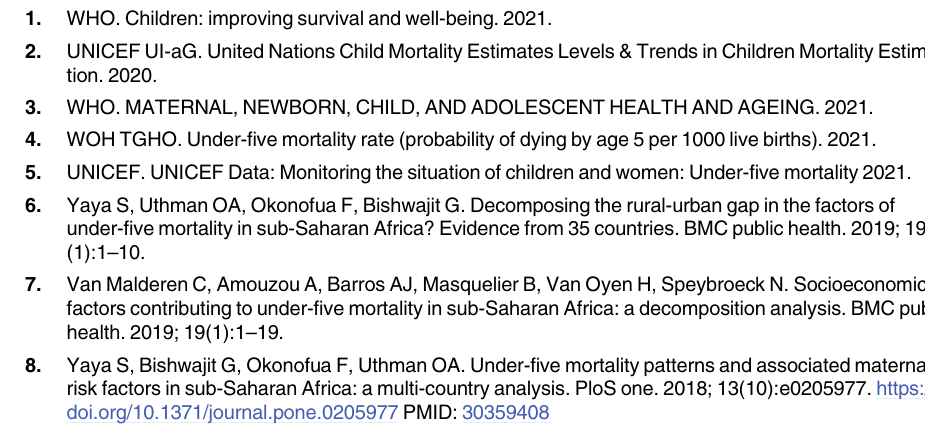
S2 Fig. The predicted geospatial map for under-five mortality in Ethiopia: 2000(A),